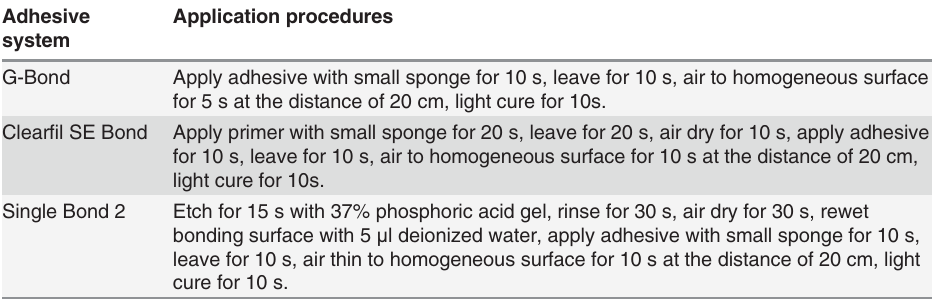
Table 2. Application procedures of the adhesive systems. Adhesive